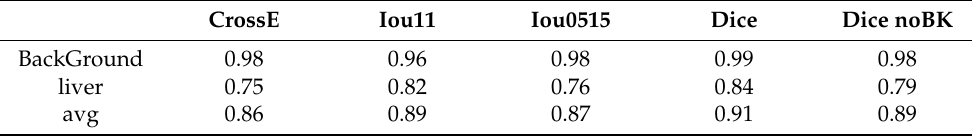
Table 3. IoU of segmentation network DeepLabV3 on CT data.